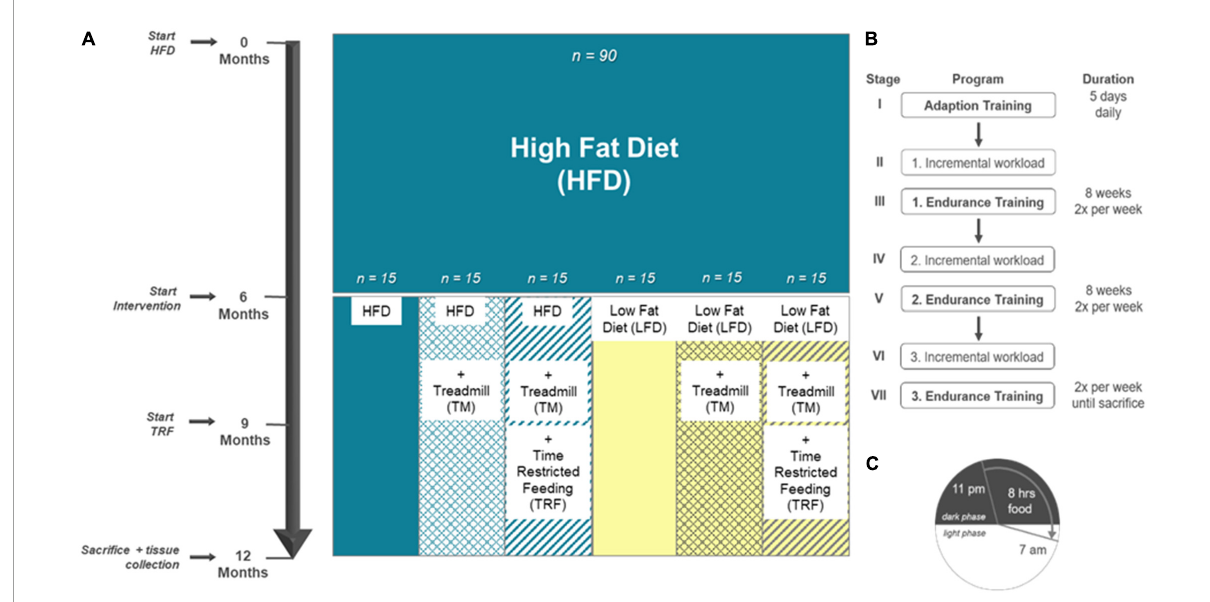
FIGURE1 Experimental design adapted to Power Guerra et al. (28). (A) Female C57BL/6J mice ( n = 90) were fed for 6 months with high-fat diet (HFD) to establish the model of diet-induced obesity. Thereafter, mice were divided into six groups. The first group remained on the HFD ( n = 90). Groups 2–6 underwent an intervention. Second group: HFD plus treadmill exercise (TM; HFD/HFD + TM, n = 15); third group: HFD plus treadmill exercise and time-restricted feeding (TRF; HFD/HFD + TM + TRF, n = 15); fourth group: dietary change to a low-fat diet (LFD; HFD/LFD, n = 15); fifth group: dietary change plus treadmill exercise (HFD/LFD + TM, n = 15), and sixth group: dietary change, treadmill training, and time-restricted feeding (HFD/LFD + TM + TRF, n = 15). When dietary change was completed, treadmill training started. After 3 months of endurance exercise, time-restricted feeding was introduced. At the end, the mice were killed, and blood and liver tissue were collected. (B) Treadmill protocol consists of seven stages with three endurance sections. Prior to endurance training, an incremental workload test was performed to adjust the maximum velocity of the run. (C) Mice in the TRF group were restricted food from 7 a.m. to 11 p.m. (16 h). Food supply was provided in the nocturnal active phase for 8